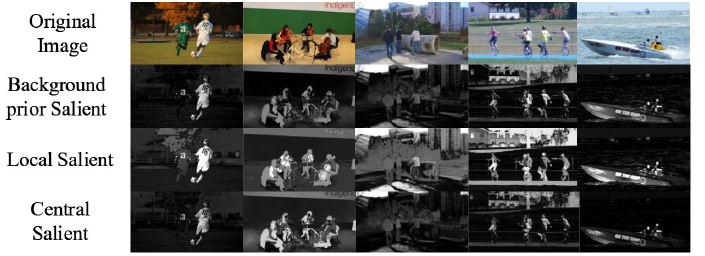
Figure 2. Example of visual characteristics saliency cues expression by different methods. Different salient features are used to represent the salient regions of the image [15,32,33]. This paper uses three color spaces (RGB, Lab and HSV), and extracts three features as image saliency features. Table 1 shows the target region pixel feature representation. Table 1. Pixel features per target area.